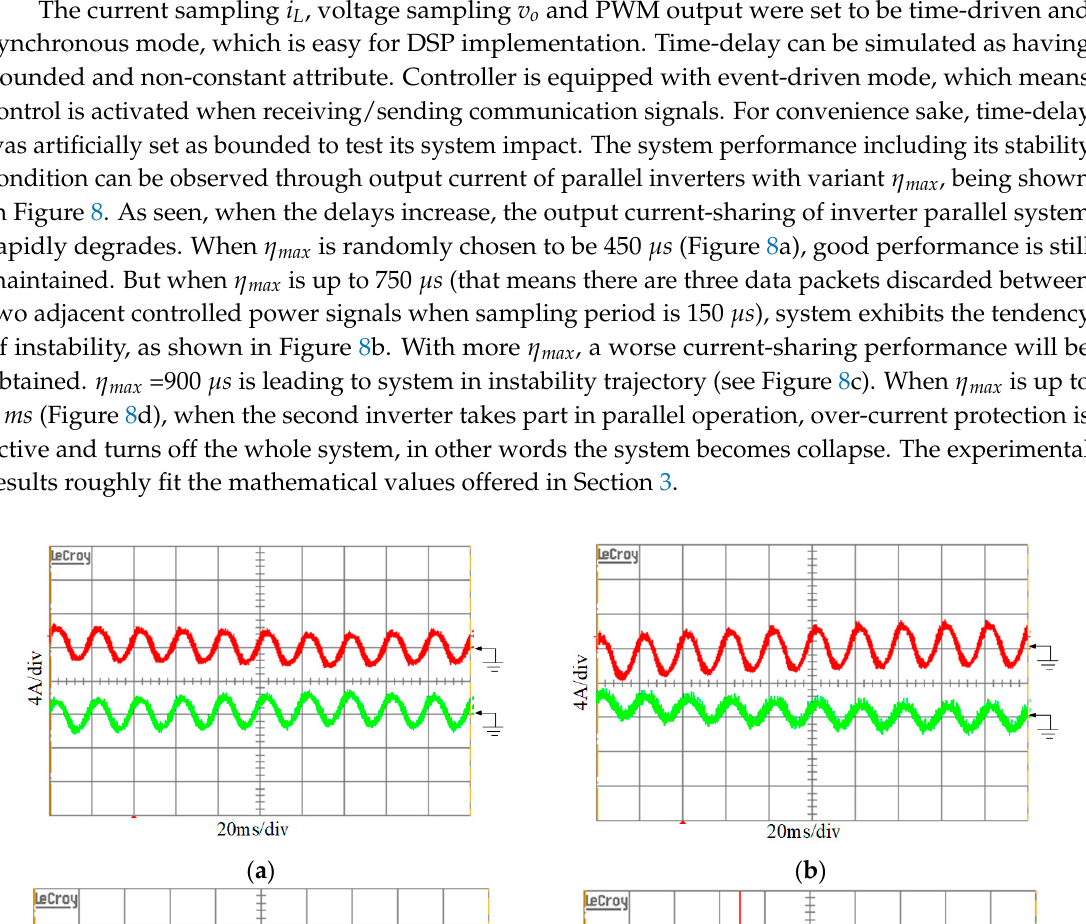
Figure 8. Output current of parallel system with network-based control in different η max . ( a ) η max = 450 μ s . ( b ) η max = 750 μ s . ( c ) η max = 900 μ s . ( d ) η max = 3 ms .